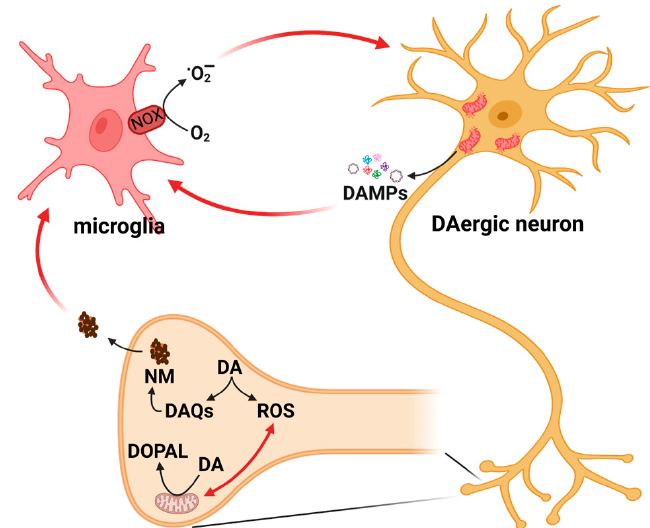
Figure 1. The vicious cycle in Parkinson’s disease, involving alterations in redox homeostasis, dys- functional mitochondria, and neuroinflammation. Mitochondria are the main site of ROS production, and, at the same time, ROS may affect mitochondrial functionality. Mitochondria can stimulate neuroinflammatory responses through the release of damage-associated molecular patterns (DAMPs). Chronic activation of microglia stimulates the production of ROS through the activation of NADPH oxidase (NOX). In dopaminergic neurons, cytosolic dopamine (DA) can auto-oxidase leading to the generation of ROS and reactive quinones (DAQs), which can either react with cellular nucleophiles or aggregate into neuromelanin (NM). The release of NM from dying neurons can fuel neuroinflammatory processes by activating microglia. Alternatively, cytosolic DA can be metabolized at the mitochondrial level into the very reactive molecule dihydroxyphenylacetaldehyde (DOPAL). The role of the oxidation product of DA in this vicious cycle will be discussed in the following